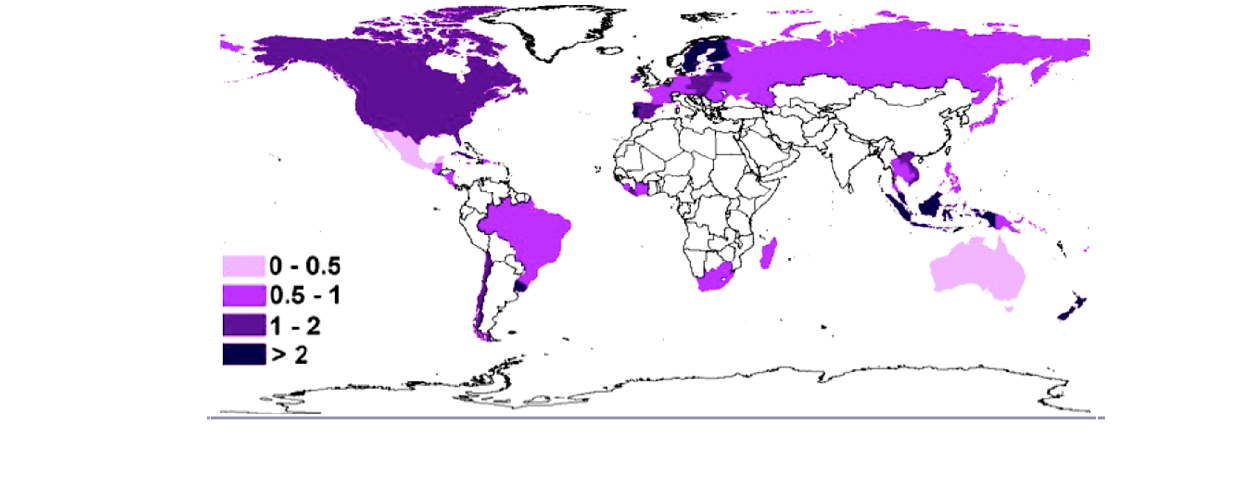
Fig. 5 . Gross increase in forest cover as a percentage national area, for the top 52 countries,